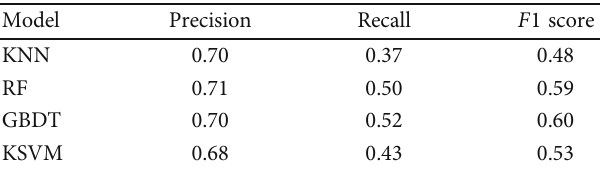
Table 6: Generalization performance indexes of the models based on the four algorithms using composite data sets.